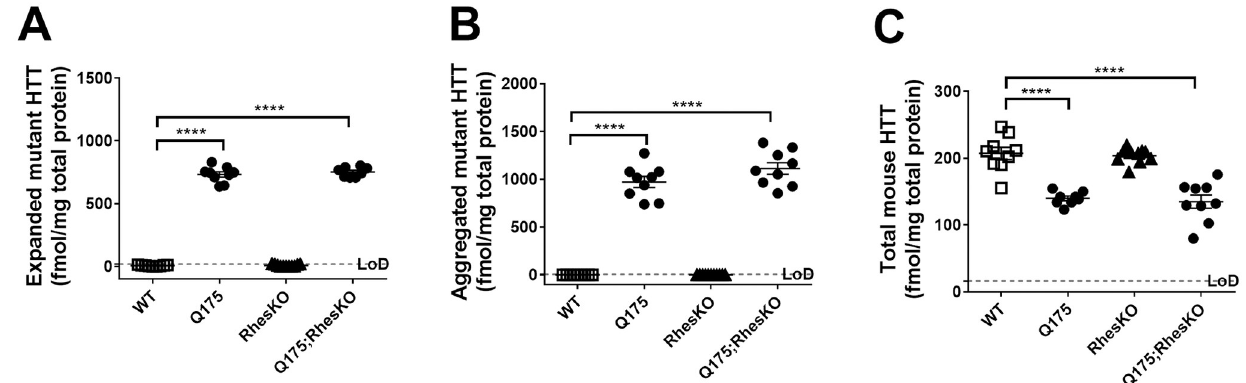
Fig 8. RhesKO did not modulate HTT levels in female Q175. MSD for soluble, aggregated and total endogenous mouse HTT was performed on 12 month striatum. Data are expressed as mean ± SEM (WT n = 9; RhesKO n = 11; Q175 n = 9; Q175;RhesKO n = 9); One-way ANOVA statistical analysis: � p < 0.05, �� p < 0.01, ���� p < 0.0001).